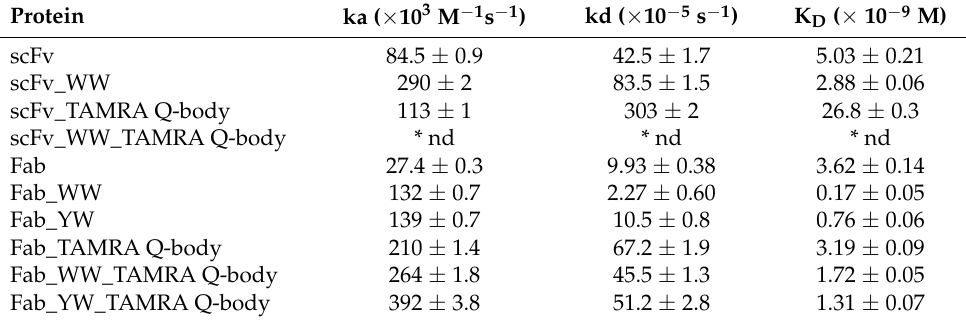
Table 1. Kinetic parameters of 3D5 antibody fragments and their Q-bodies with biotinylated His 6 peptide. An average and a standard error from global fitting are shown (n = 3).